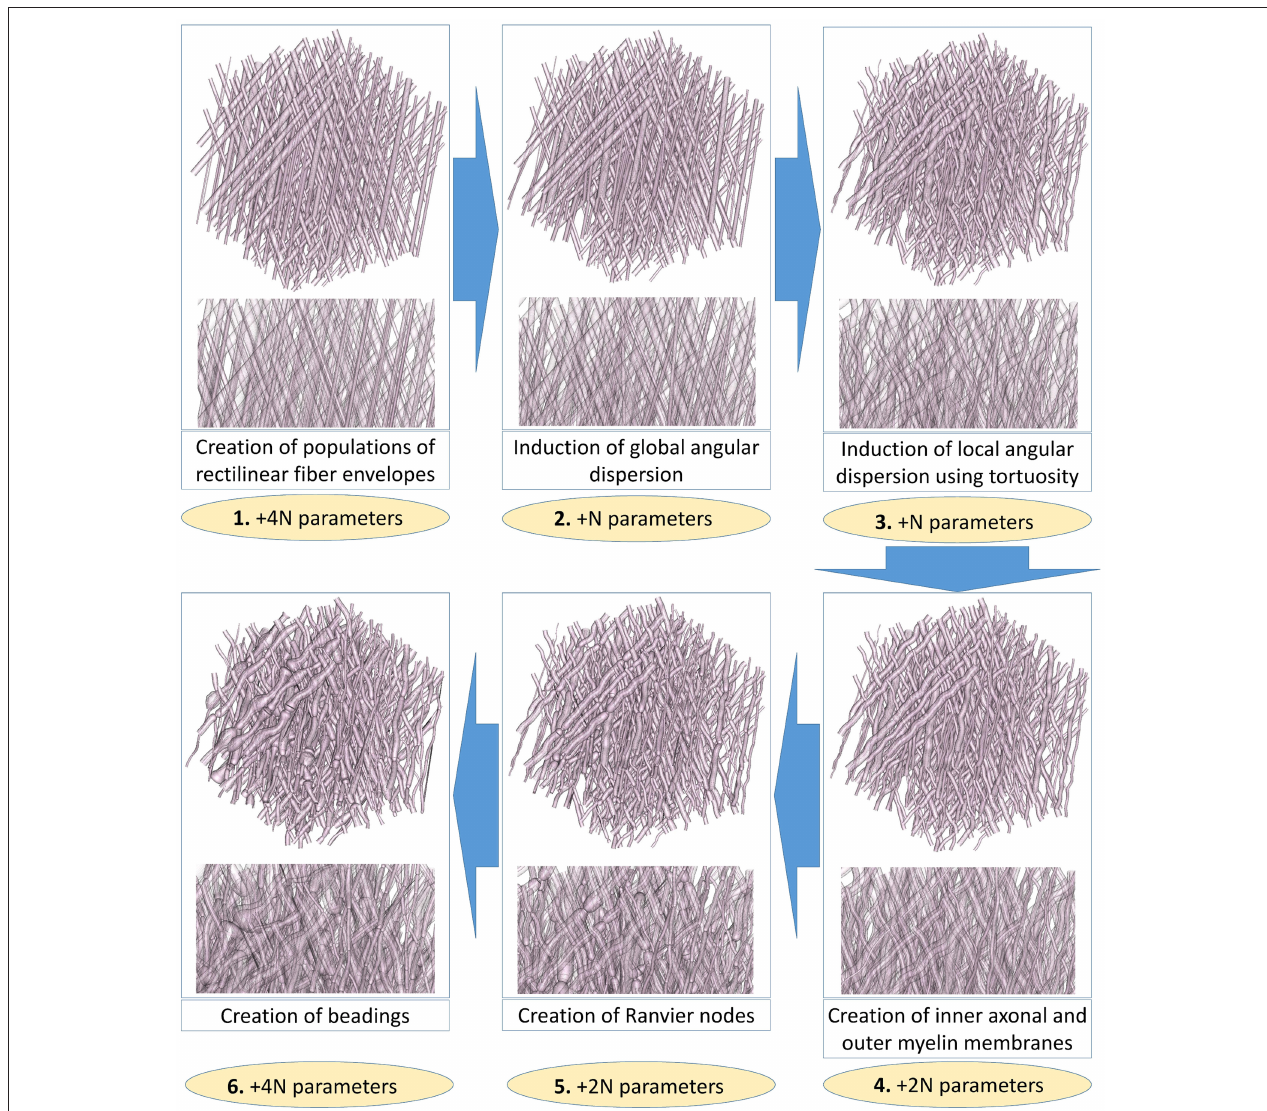
FIGURE 6 | (1) Surface renderings corresponding to three fiber populations with mean diameters 1.5, 2.0, and 3.0 µ m, respectively with intracellular volume fraction of 0.05 each. N is the number of populations in general (here N 3). (2) Global angular dispersion is induced (4.7, 2.5, and 2.8 ◦ per population). (3) Tortuosity is induced, = enabling to reach 10 ◦ of angular dispersion for each population. (4) Creation of the myelin sheath. (5) Creation of Ranvier nodes with mean ratio 1,000 between internodal length and node width. (6) Creation of beadings with 20.0 µ m mean inter-beading length and beading magnitude ratios of 1.7, 1.5, and 1.2,